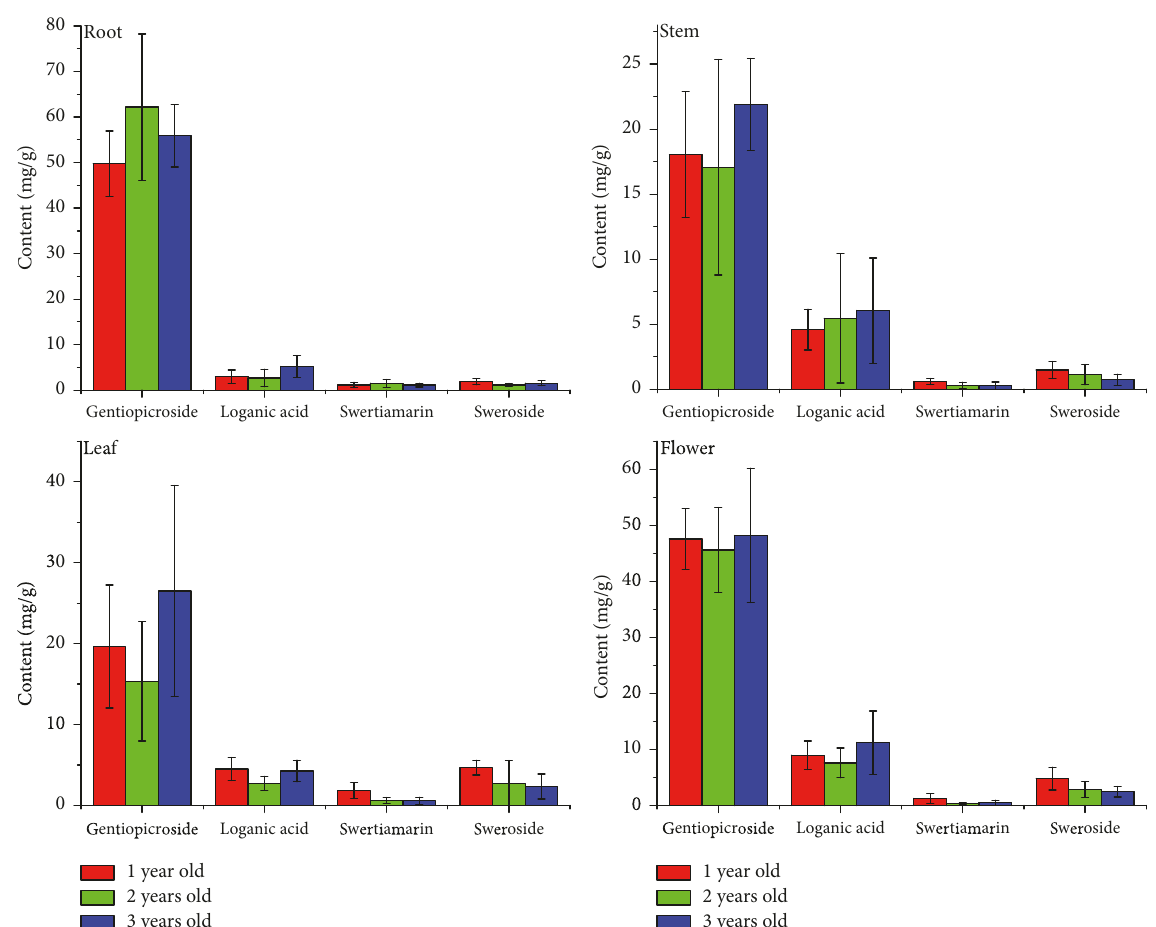
Figure 3: Quantitative variation of iridoid glycosides between cultivation ages. (Description: this figure shows the quantitative variation of iridoid glycosides between cultivation ages of different organs of G. rigescens resources based on HPLC method. The content of metabolites is represented as the average